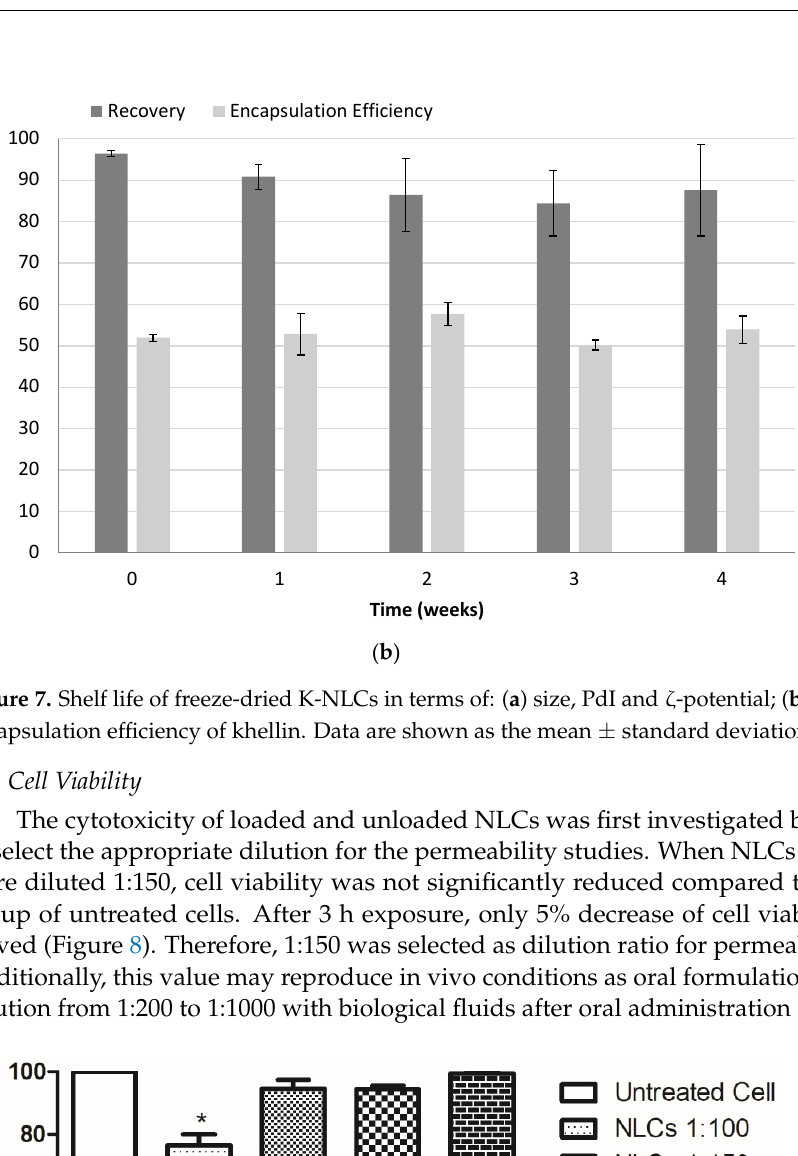
( b ) Figure 8. Cytotoxicity on Caco-2 cell line (% vs. untreated cells) of ( a ) NLCs and ( b ) K-NLCs at different dilutions (1:100, 1:150, 1:200, and 1:300) after 3 h of exposure. Data are shown as mean ± standard error ( n = 3). * = p < 0.05. 2.9. Permeability Study on Caco-2 Cells Caco-2 cells are considered the most widely used predictive model to estimate passive diffusion, active transport processes, paracellular permeability, and active efflux across the intestinal epithelium [31]. In particular, Caco-2 cells are rich in mucin content as previously demonstrated [32]. For this reason, Caco-2 cell line also represent a suitable model to preliminarily predict the effects of mucus layer of the intestinal epithelium during permeation. In the present study, the permeability of khellin by passive diffusion was evaluated by comparing unformulated khellin (PBS solution) and formulated khellin (K-NLCs) at the same concentration, after 2 h incubation in GIF plus 2 h in SIF. The apparent permeability (P app ), measured after 2 h incubation with Caco-2 cells, was (1.15 ± 0.06) × 10 − 8 cm/s for khellin solution and (4.96 ± 1.25) × 10 − 6 cm/s for K-NLCs. This enhancement could be ascribed to the formulation surfactants [33,34]. Specifically, Labrafil M 1944 CS works as a penetration enhancer and solubilizing agent of poorly water-soluble active ingredients [18], while Brij S20 has been reported to present inhibitory effects on Pgp function [29,35]. Therefore, this study demonstrated that lipid nanoparticles increased khellin permeability across the Caco-2 cell monolayer and mucus